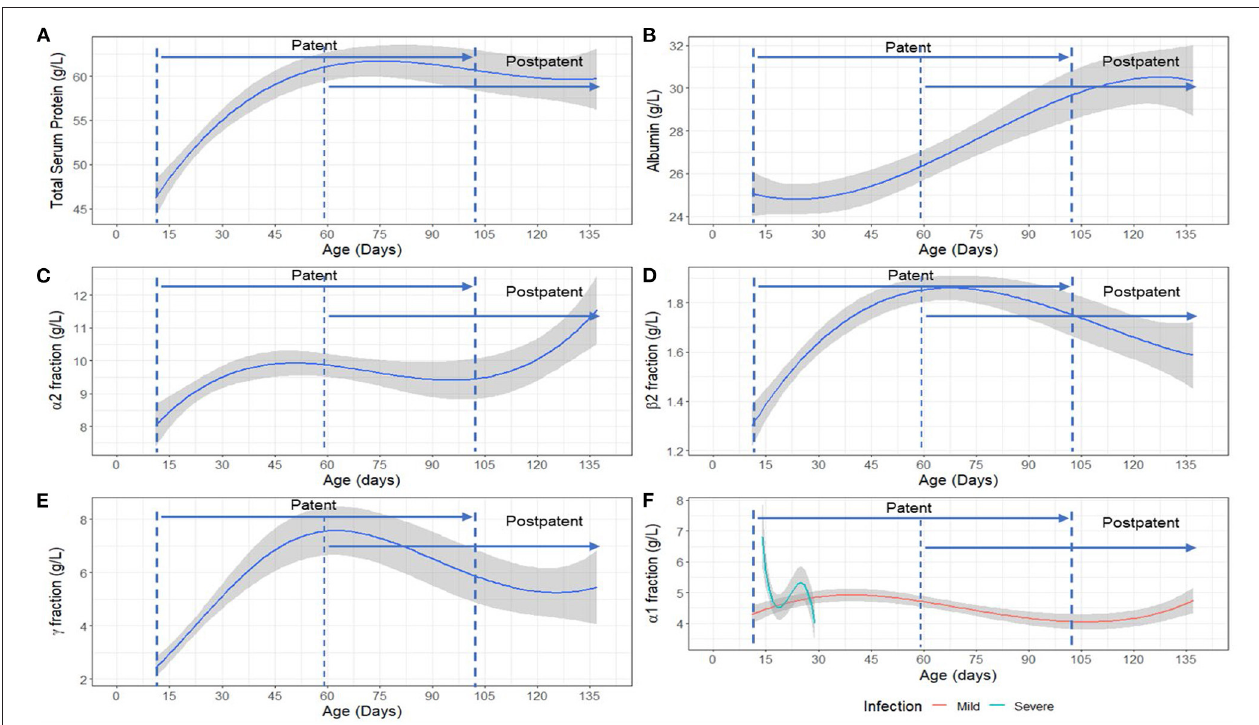
FIGURE 3 | Model estimated relationship between (A) Total serum protein, (B) Albumin fraction, (C) α 2 fraction, (D) β 2 fraction, (E) γ - globulin fraction and age, and (F) α 1 fraction with age and disease severity (mild/severe) in Australian sea lion ( Neophoca cinerea ) pups. Mild: TPP ≥ 60 g/L and PCV > 35%; Severe: TPP < 60 g/L and PCV ≤ 35%. The statistical models for β 2 and γ -globulins were fitted on a log scale, but model derived back-transformed means (emmeans package R) are presented in figures. The shaded area represents the 95% confidence interval. Patency periods adapted from Marcus et al. (